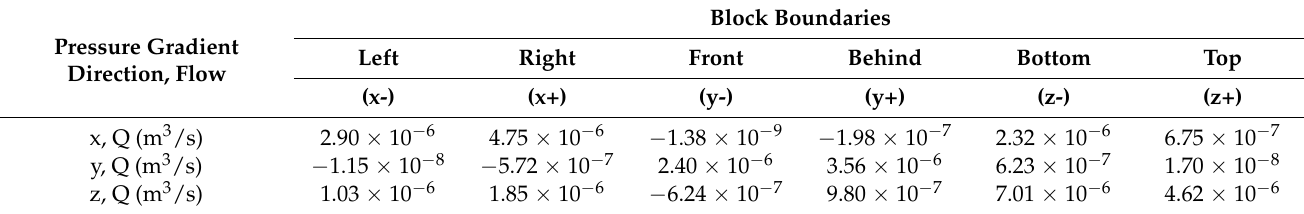
Table 2. Flow through DFN block boundaries with pressure gradient in x, y, and z directions. Block Boundaries Pressure Gradient Left Right Front Behind Bottom Top Direction, Flow